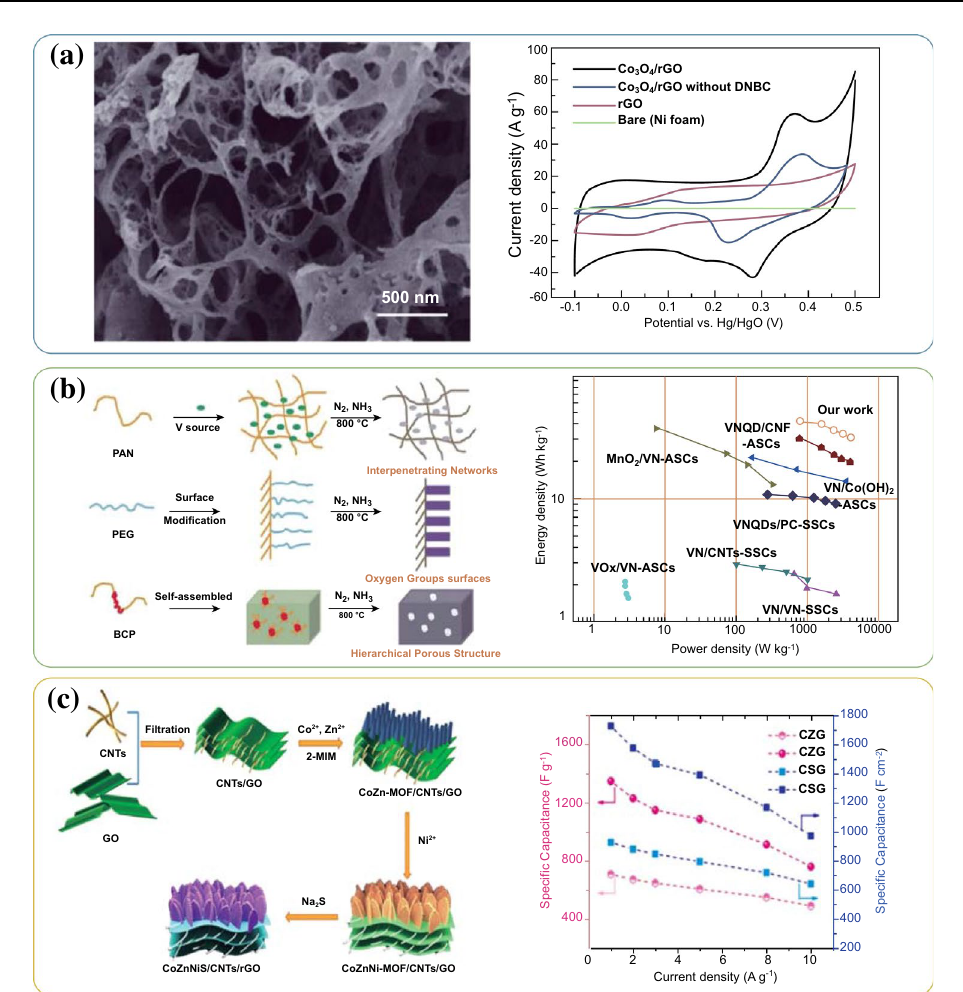
Fig. 6 a SEM image of the 3D graphene frameworks/Co 3 O 4 composites and CV curves at 50 mV s −1 of the various sample. Adapted with permission from Ref. [42] Copyright 2017 Wiley–VCH. b Schematic representation of the fabrication strategy and Ragone plots of the VN/C. Adapted with permission from Ref. [43] Copyright 2018 Springer. c Schematic illustration of the preparation of the CoZnNiS/CNTs/rGO com- posite and their volumetric and gravimetric capacitance at different current densities. Adapted with permission from Ref. [45] Copyright 2020